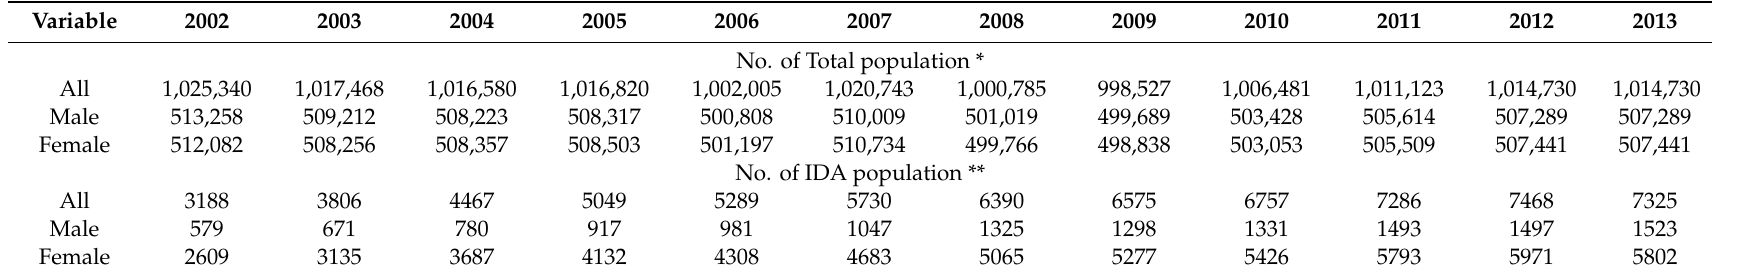
Table 1. Distribution in the sample cohort population and IDA-diagnosed patients,